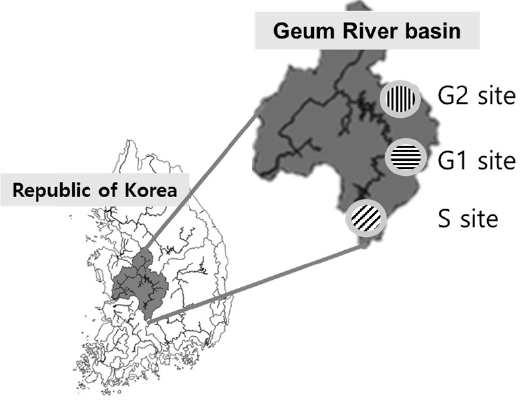
Figure 1. Location of the research area. Table 1. The latitude and longitude of research areas (Sampling point). Mining Site